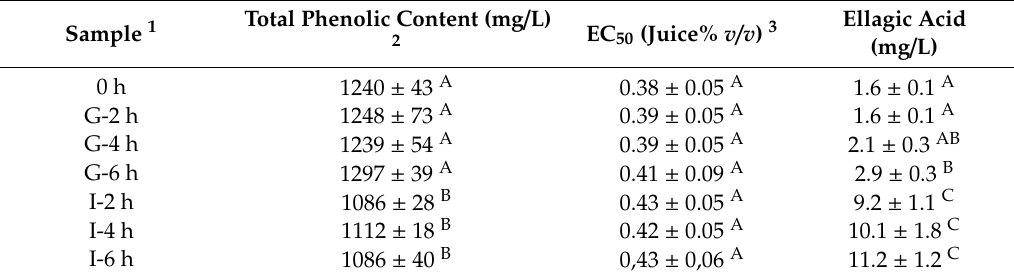
Table 2. Mean values of total phenolic content, antioxidant activity and ellagic acid concentration of pomegranate juice (Ermioni variety) during the simulated digestion